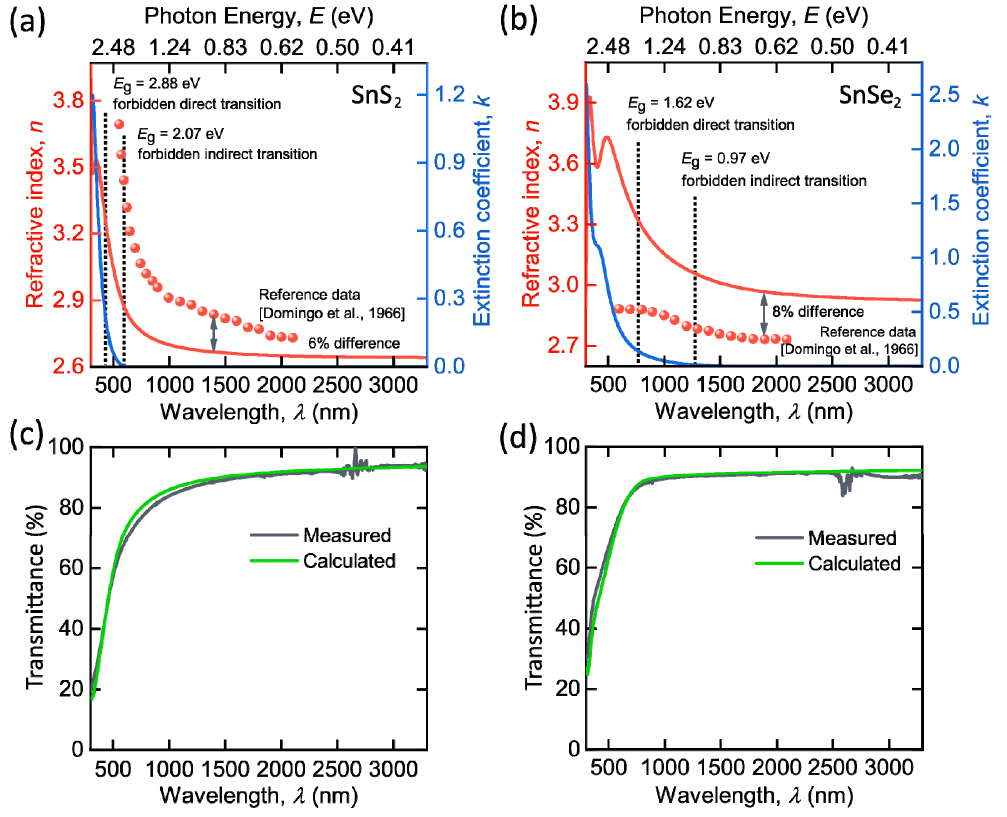
Figure 3. Linear optical properties of SnS 2 and SnSe 2 . Dielectric function of ( a ) SnS 2 and ( b ) SnSe 2 . For comparison, we included refractive indices (red circles) and electronic transitions (dashed lines) determined by Domingo et al. [26]. Measured and calculated transmittance for ( c ) SnS 2 and ( d ) SnSe 2 on quartz. Tabulated optical constants for SnS 2 and SnSe 2 are collected in Table A1.